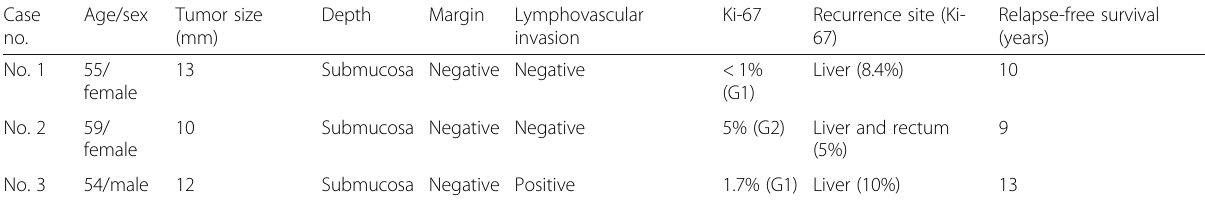
Table 1 Summary of pathological findings of the primary tumor and recurrence Case